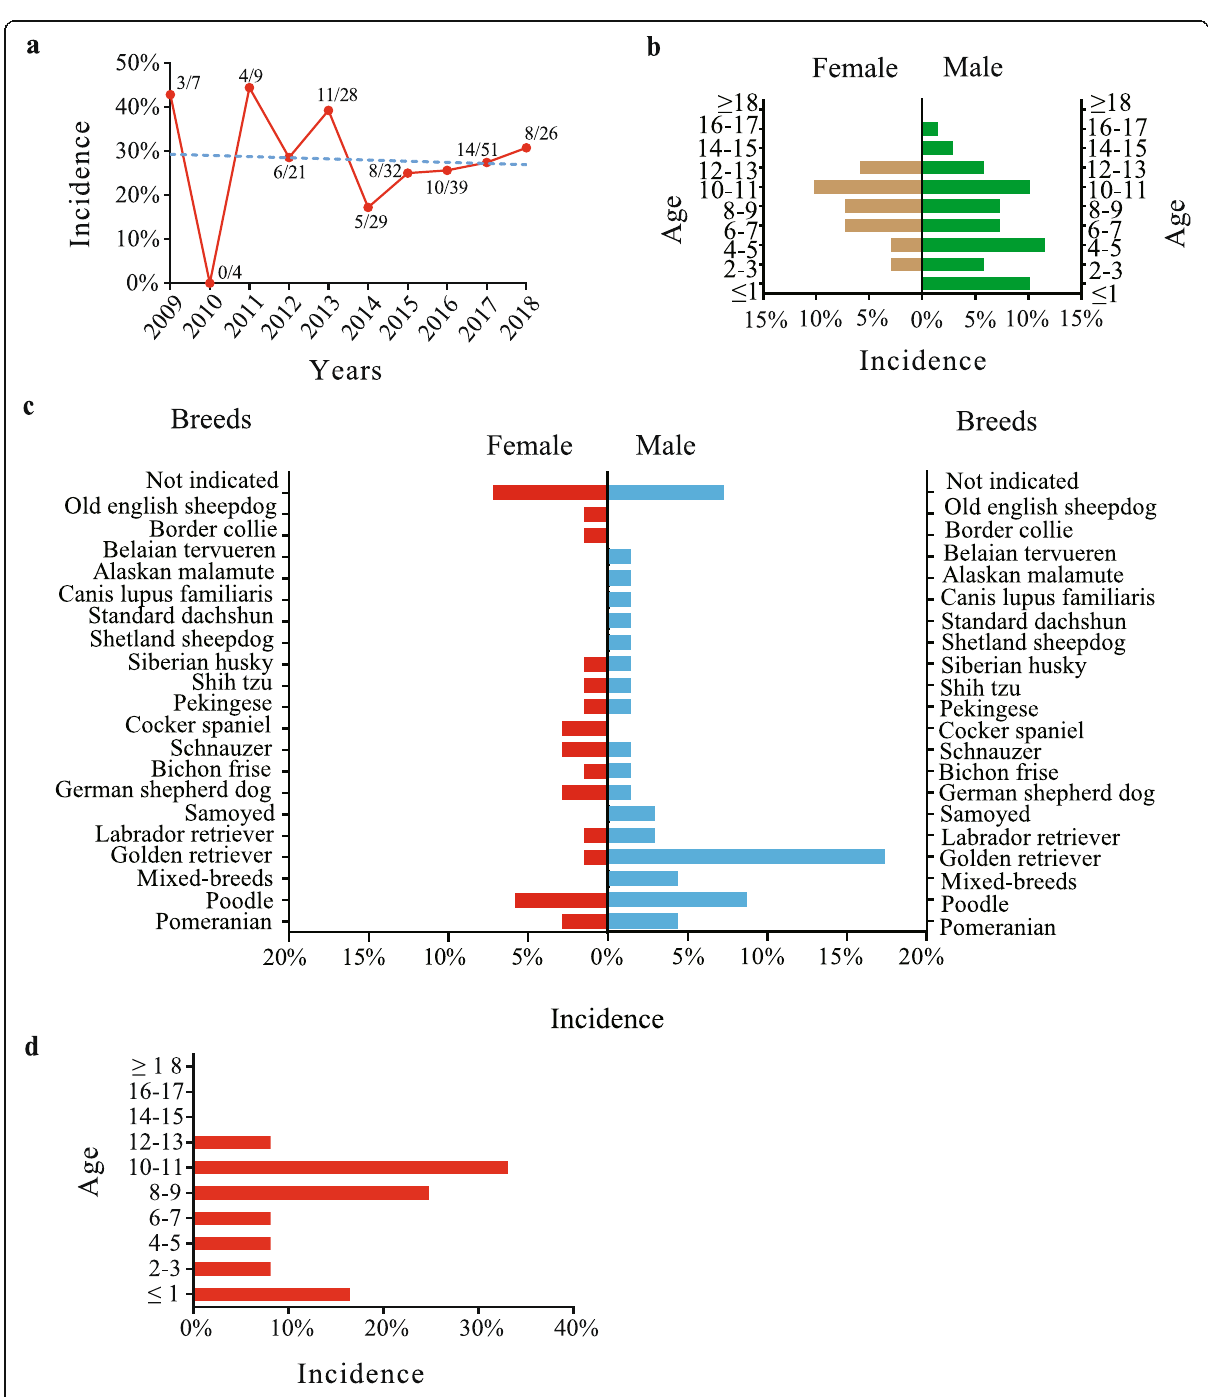
Fig. 3 Correlation of sex, age and breed with cutaneous tumors in pet dogs. a Dynamic changes of cutaneous tumors incidence in pet dogs from 2009 to 2018. The dotted line represents linear regression. b Incidence of cutaneous tumors in male and female pet dogs at different ages. c Incidence of cutaneous tumors in different breeds of male and female pet dogs. d Incidence of cutaneous tumors in Golden Retrievers at different